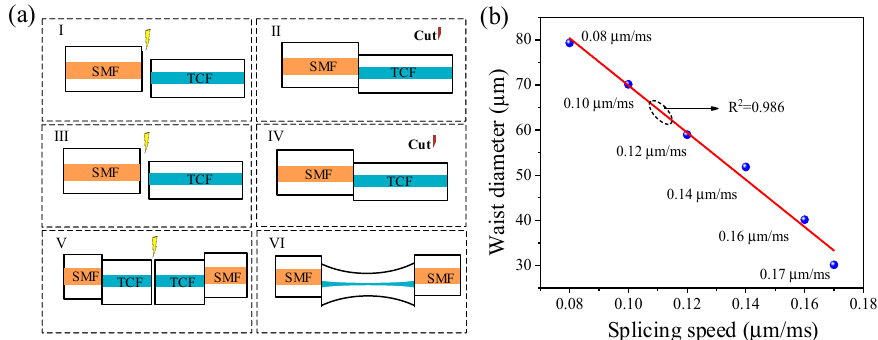
Figure 3. ( a ) The fabrication flow of t -TCF structure, ( b ) the relation between the fusion speed and the diameter of taper waist.